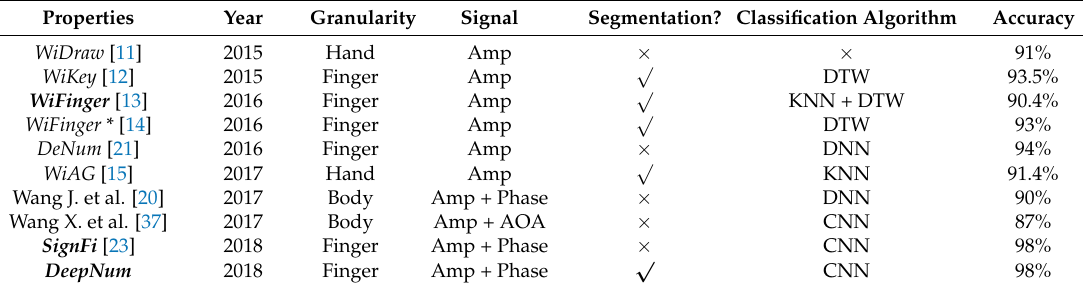
Figure 10. Impact of user diversity.